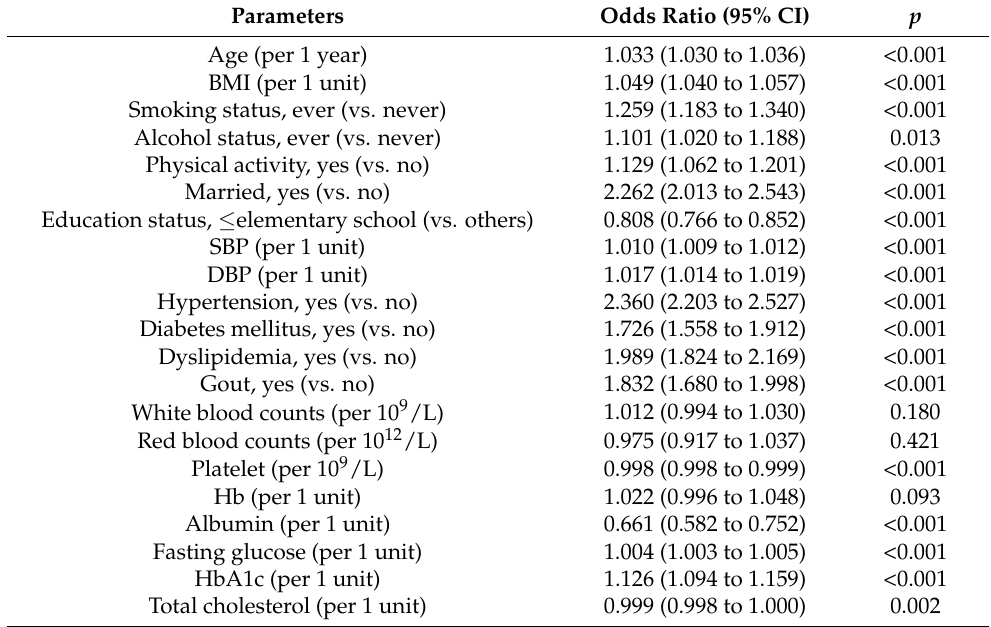
Table 2. Association between parameters and KSD in univariable binary logistic analysis (N =